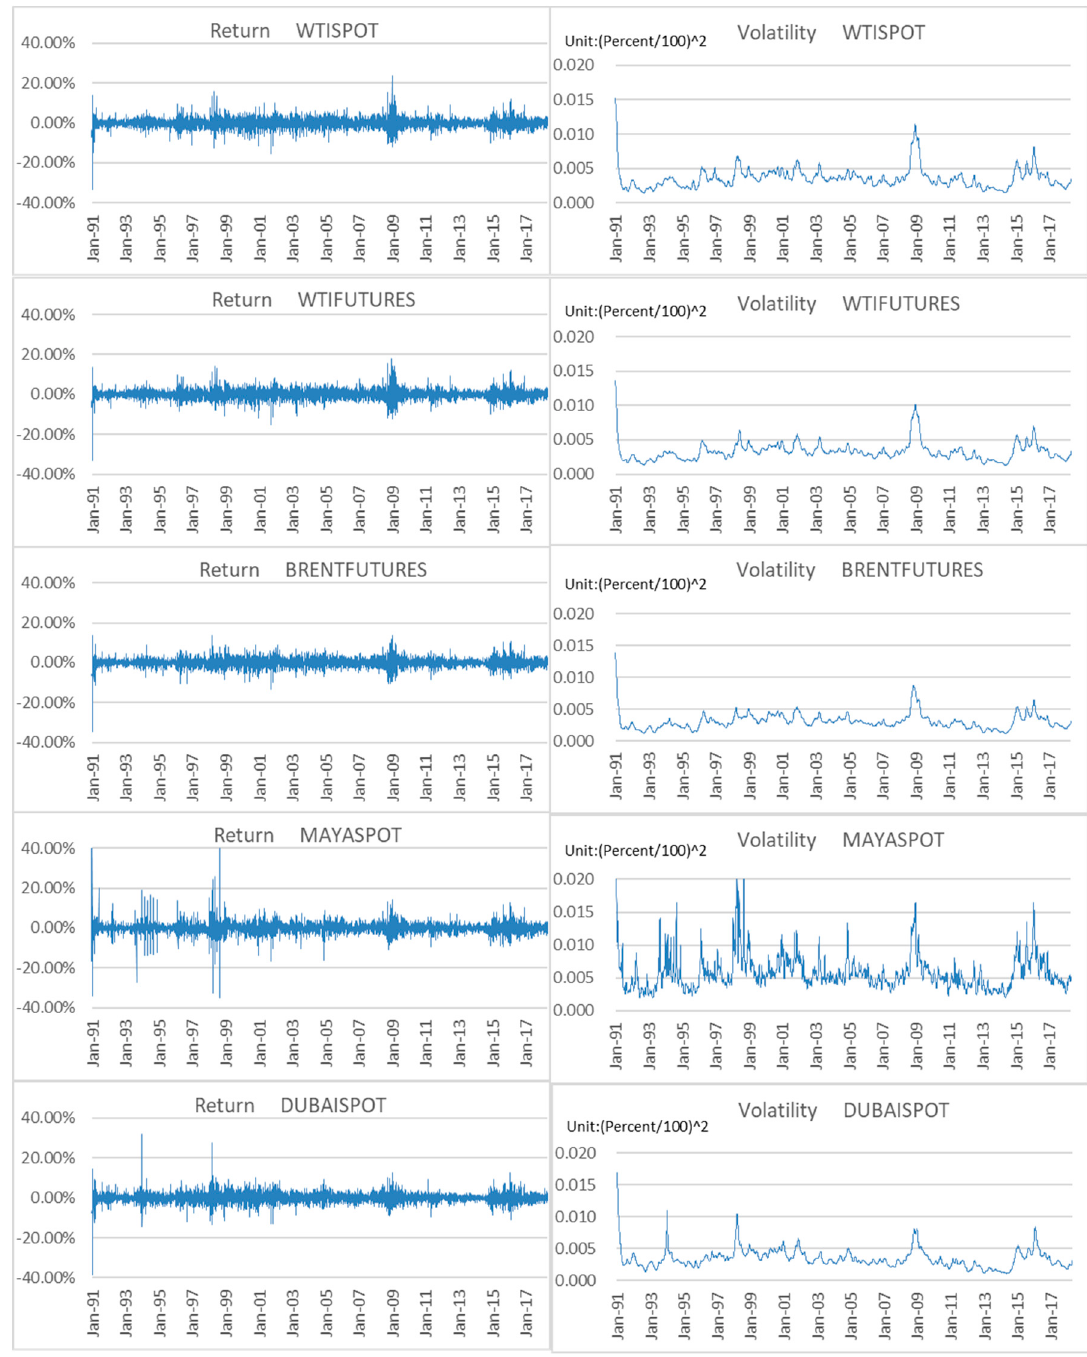
Figure 1. Time series plots of returns and volatility. Data Source: Bloomberg: WTISPOT: West Texas Intermediate (WTI) crude oil spot price; WTIFUTURES: WTI crude oil futures price; BRENTFUTURES: Brent crude oil futures price; MAYASPOT: Maya crude oil spot price; DUBAISPOT: Dubai crude oil spot price.